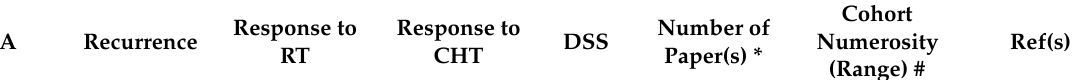
Table 4. Tissue miRNAs associated with prognostic features in LSCC